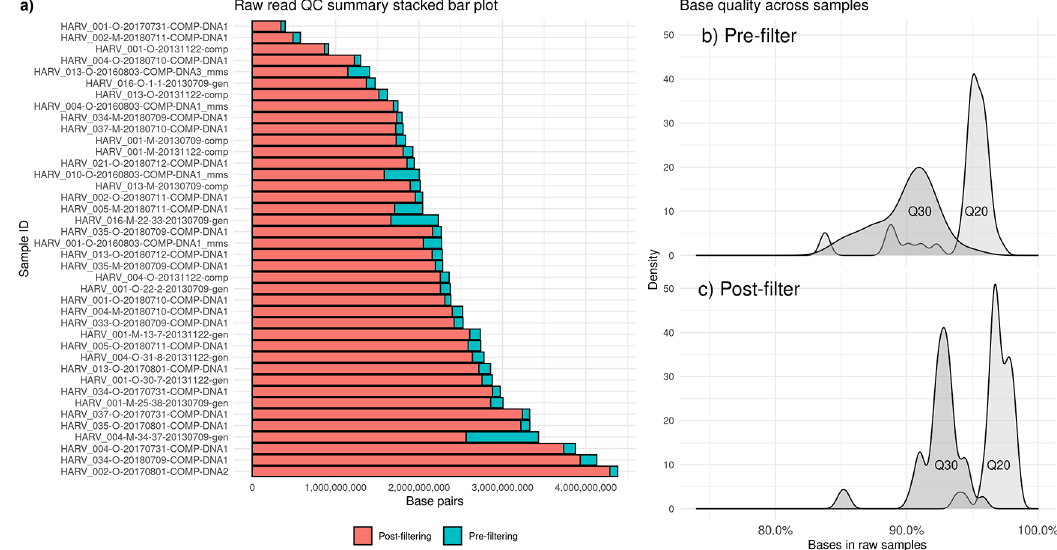
Figure 1. Quality control results for short reads using the Fastp software (Chen et al. , 2018). Short-read metagenomic samples are from the Harvard Forest site of the National Ecological Observatory Network (NEON). a) Counts of read pairs before (blue) and after (red) quality control steps. b) Base quality at Q30 (dark gray) and Q20 (light gray) before filtering. c) Base quality at Q30 (dark gray) and Q20 (light gray) after